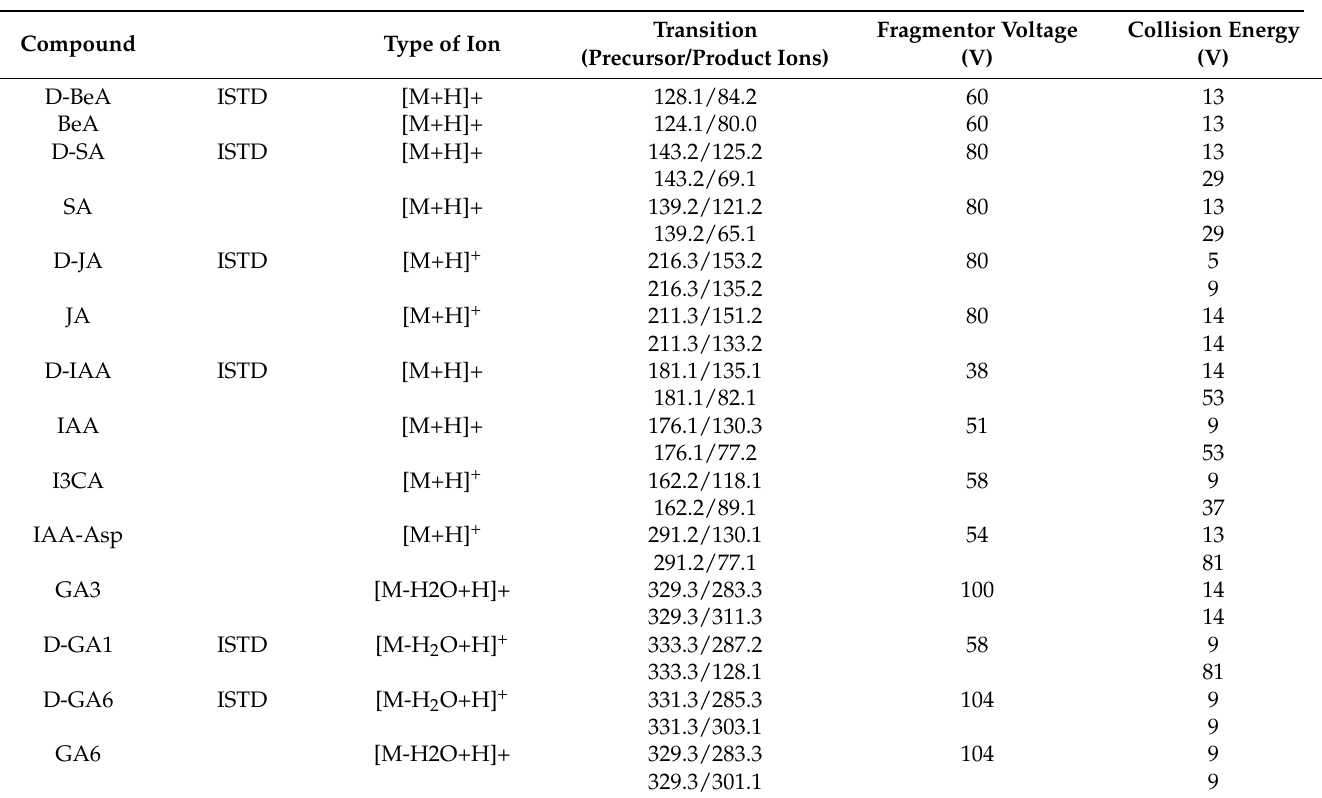
Table 4. MRM parameters at positive ion mode (+ESI), capillary voltage 4 kV, gas temperature 350 ◦ C, gas flow 12 L/min and nebulizer pressure 35 psi. MassHunter software was used to control the LC–MS/MS system and in data analysis. For MRM parameters optimization MassHunter Optimizer was used. Monitored compounds: [ 2 H 5 ]benzoic acid (D-BeA), benzoic acid (BeA), [ 2 H 4 ]salicylic acid (D-SA), salicylic acid (SA), [ 2 H 5 ]jasmonic acid (D-JA), jasmonic acid (JA), [ 2 H 5 ]indole-3-acetic acid (D-IAA) indole-3-acetic acid (IAA), indole-3-carboxylic acid (I3CA), indole-3-acetyl-aspartic acid (IAA-Asp), gibberellic acid A 3 (GA3), [ 2 H 2 ]gibberellic acid A 1 (D-GA 1 ), [ 2 H 2 ]gibberellic acid A 6